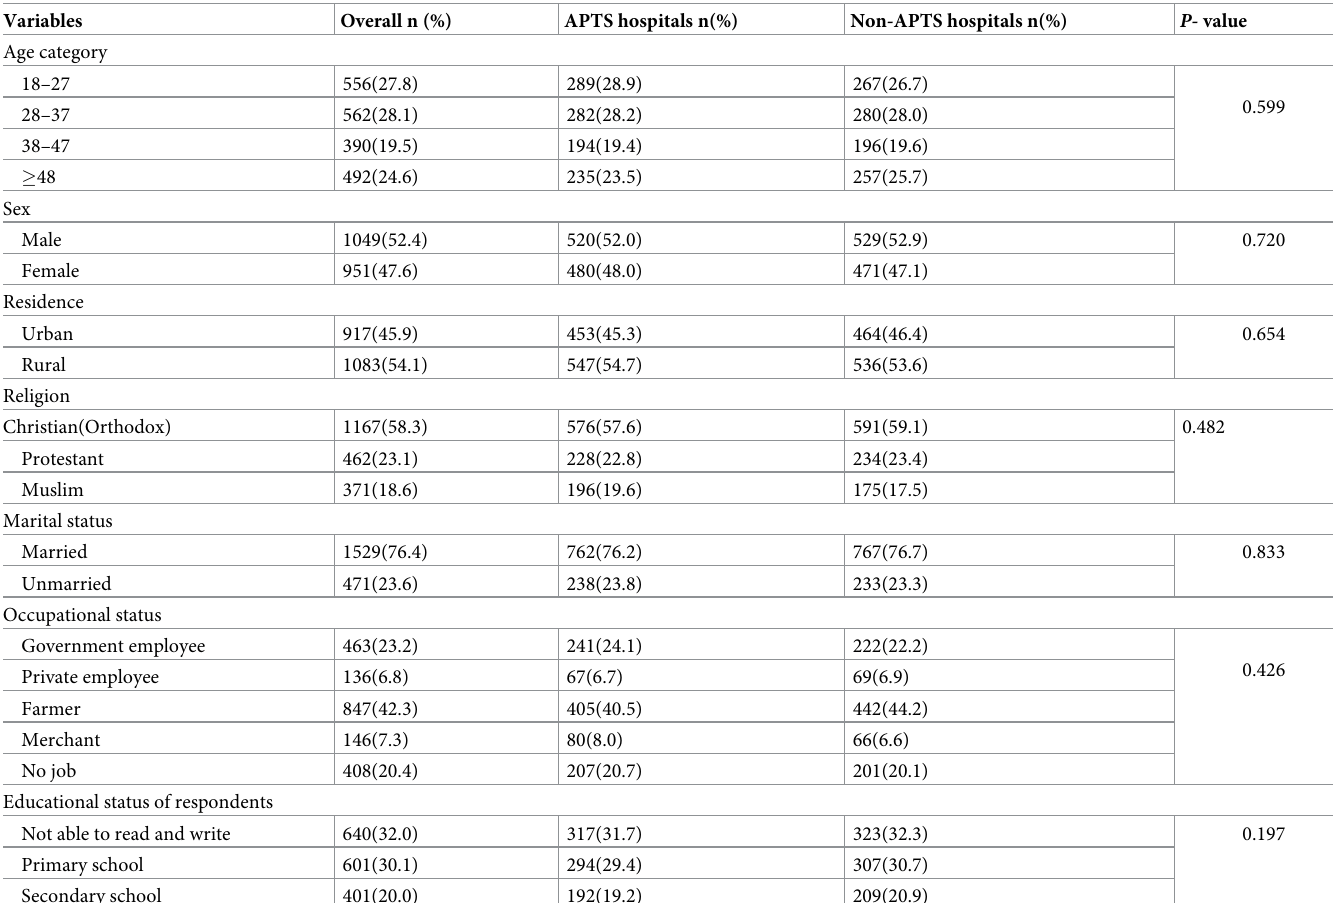
Table 1. Comparison of the socio-demographic characteristics and health care measures between study population of APTS and Non-APTS primary hospitals.